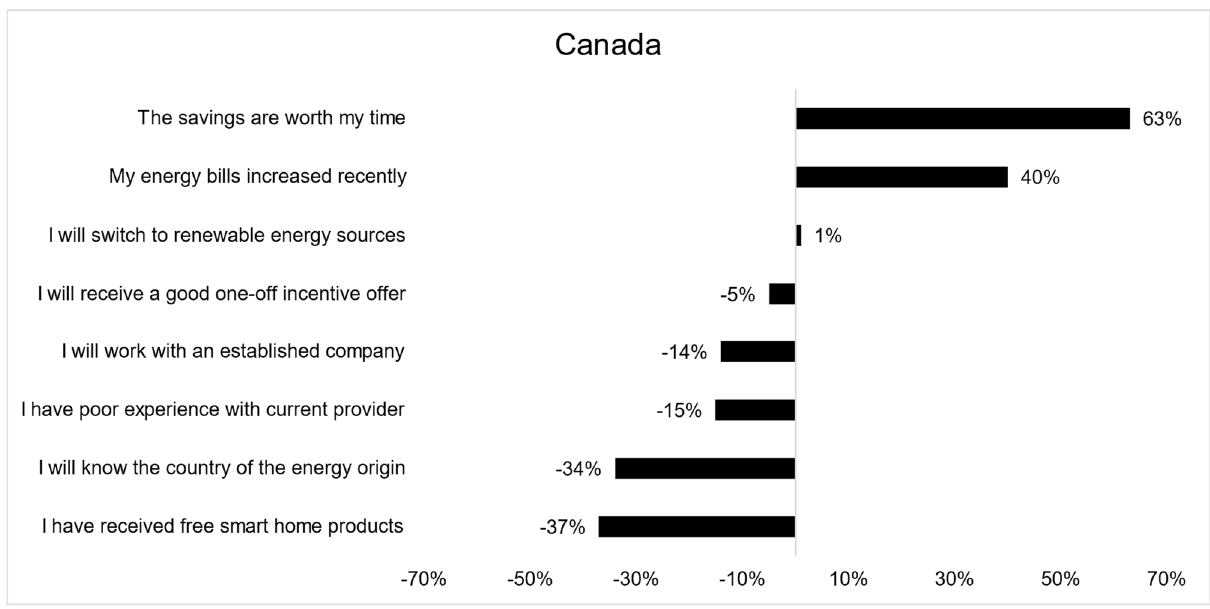
Figure 4. Utility attributes for various energy provider reasons in the United States . Source: own study.